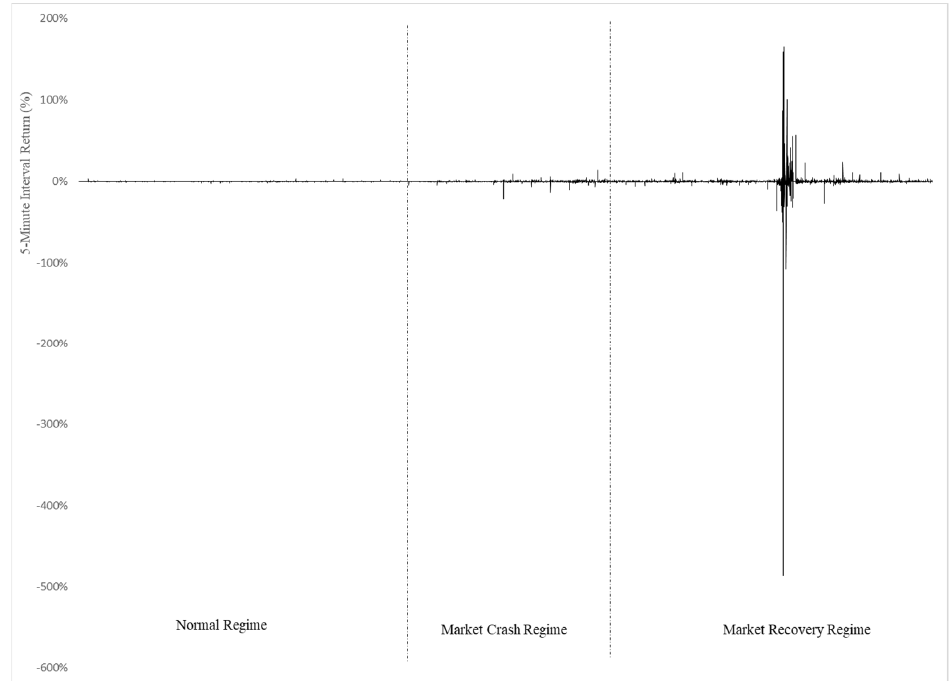
Figure 3. Individual 5-minute interval returns in the OIL market. Figure 3 presents each five-minute interval return in the OIL market across the sample period and three market regimes (i.e., Normal Market Regime, Market Crash Regime, and Market Recovery Regime). The x-axis presents the pe- riod of 1 January 2020, to 12 May 2020. The y-axis presents the 5-min interval return